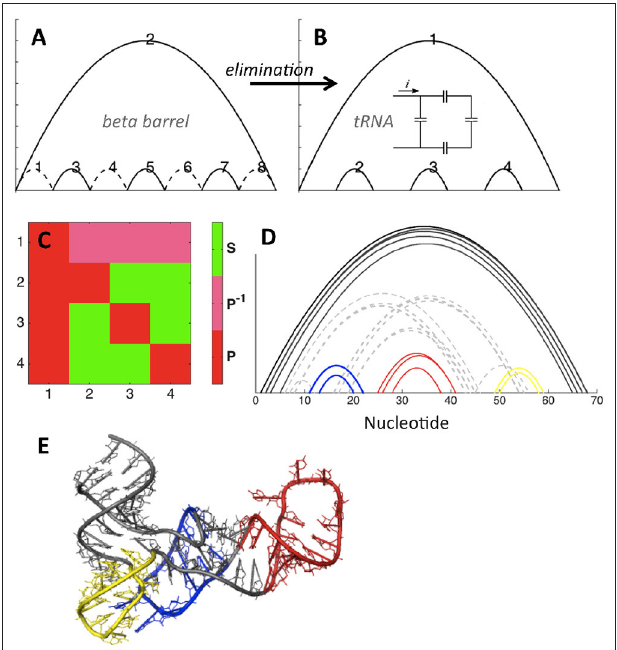
FIGURE 5 | tRNA topology (PDB ID 4kr2). (A,B) Elimination of contacts within the beta barrel motif (A) leads to the tRNA motif (B) . Topologically equivalent capacitor schematic shown in the inset. (C) Relations matrix for (B) . (D) Contacts between ribonucleotides of tRNA, PDB ID 4kr2. Cutoffs: 3.5, 6. Color and dashes added for emphasis. (E) tRNA structure, colored as shown in (D) .